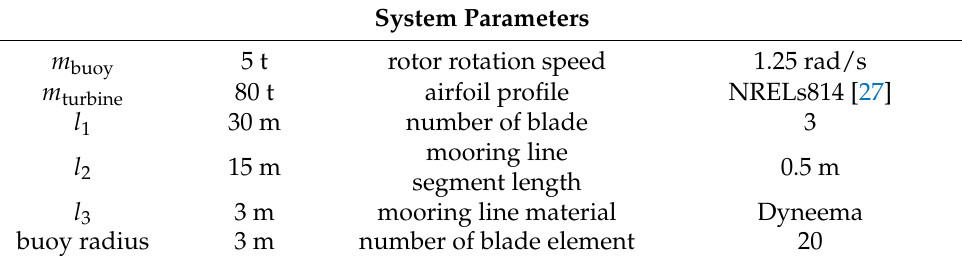
Table 2. The parameters of the turbine, buoy and mooring